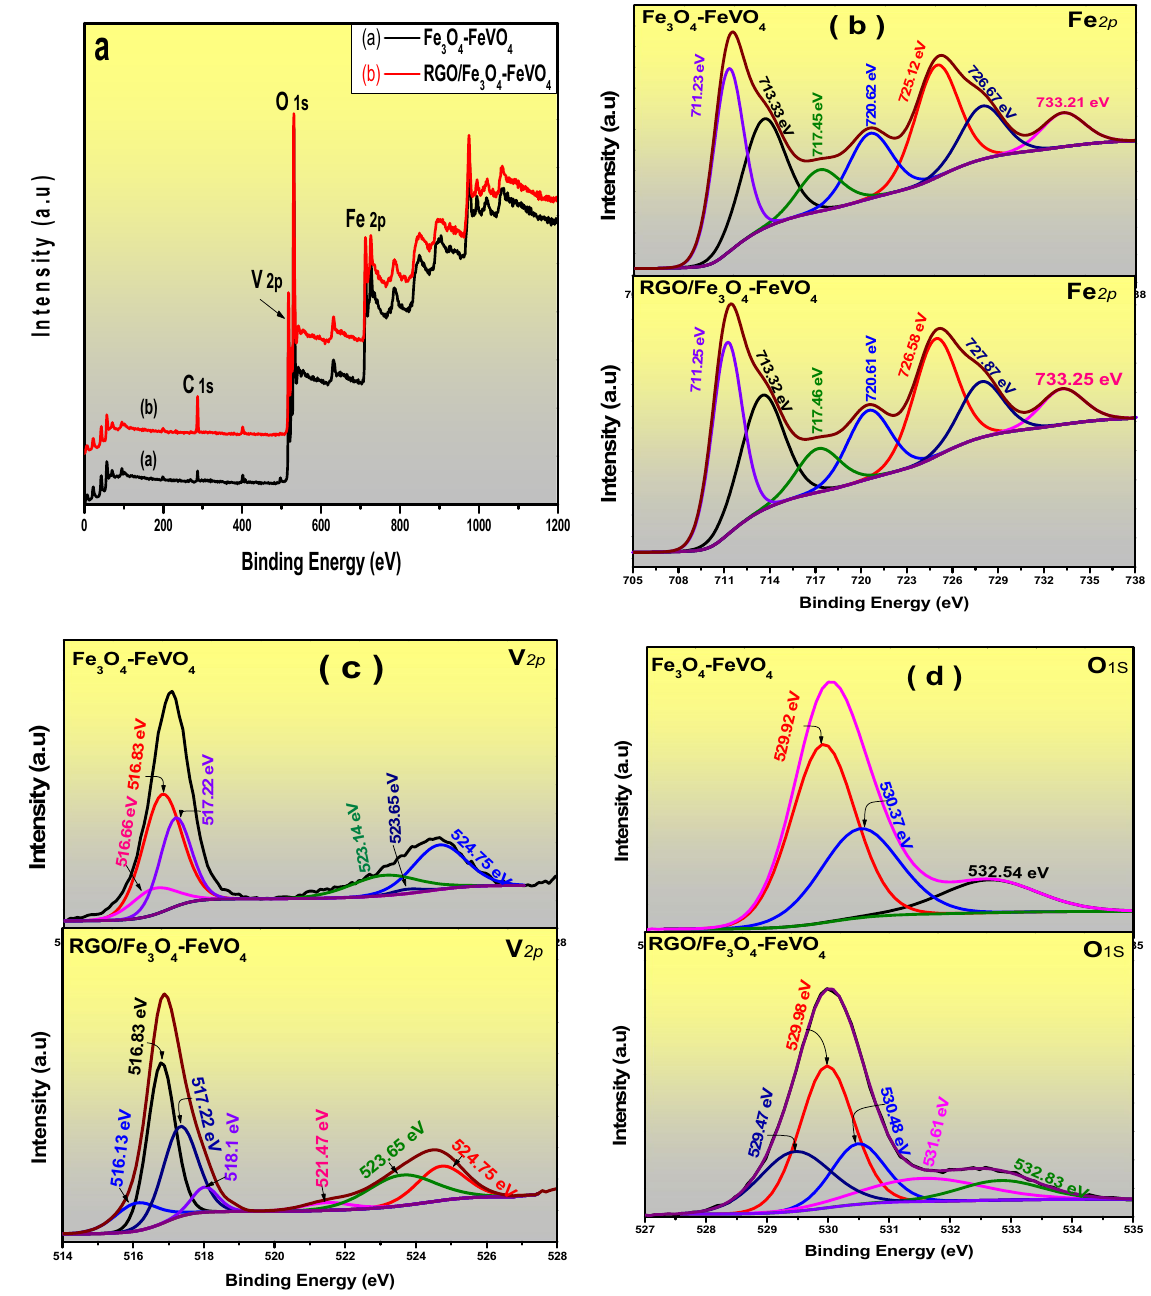
Figure 4. XPS spectra of Fe 3 O 4 –FeVO 4 and 10%RGO/Fe 3 O 4 –FeVO 4